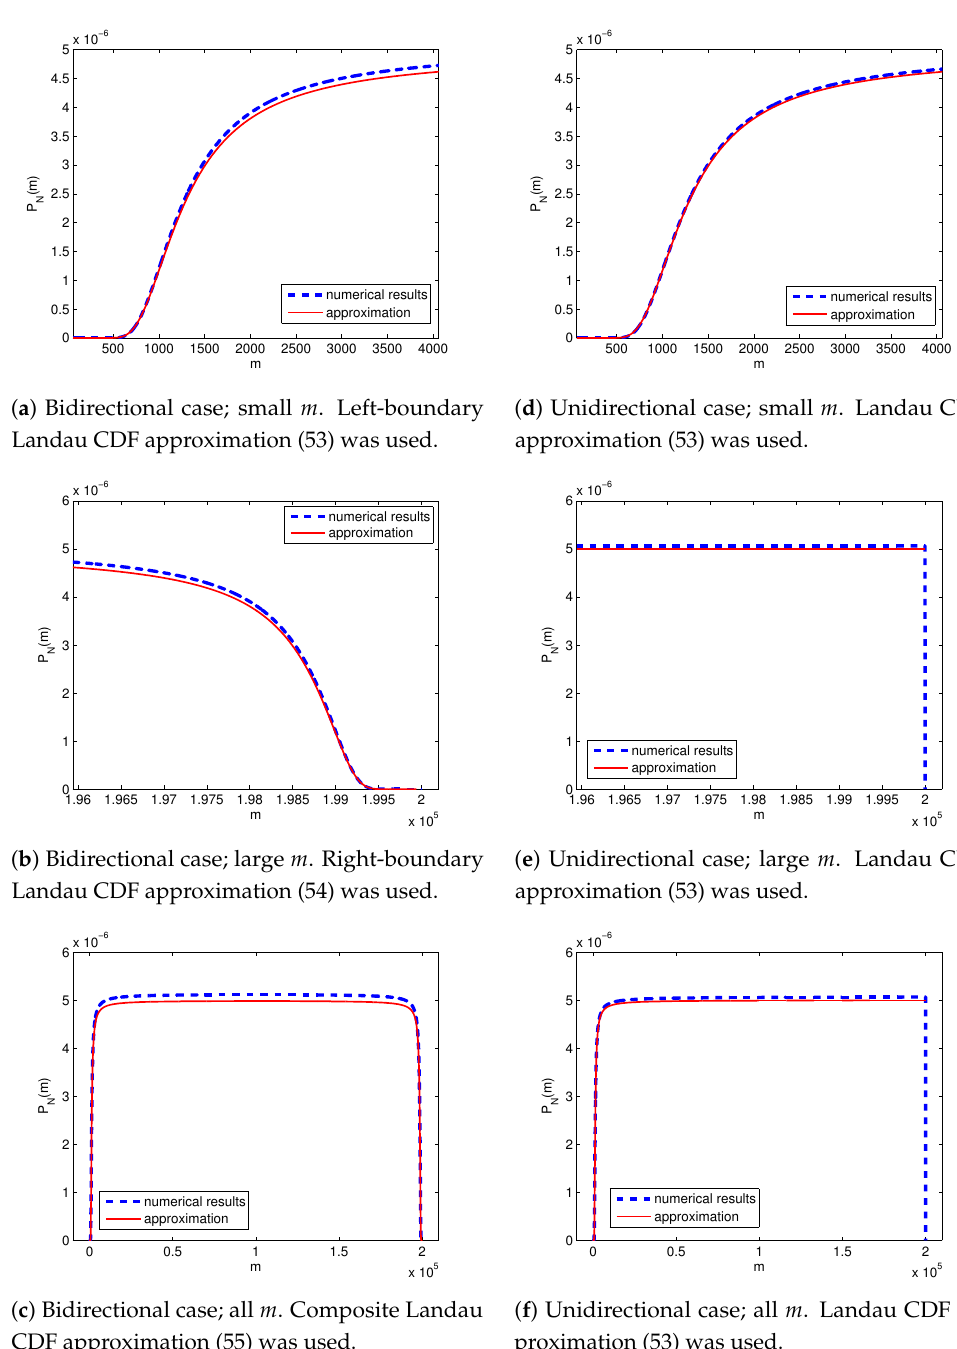
Figure 4. The probability P N ( m ) of having m resistant cells in a total population of N cells as calculated numerically (blue dashed lines) and its asymptotic approximations (53), (54) and (55) (red solid lines). The population started from two cells, one sensitive and one resistant, and was left to grow until it had consisted of N = 2 × 10 5 cells. ( a – c ) Bidirectional case: the probabilities of resistance acquisition and loss are µ = λ = 10 − 3 . ( d – f ) Unidirectional case: µ = 10 − 3 , λ =